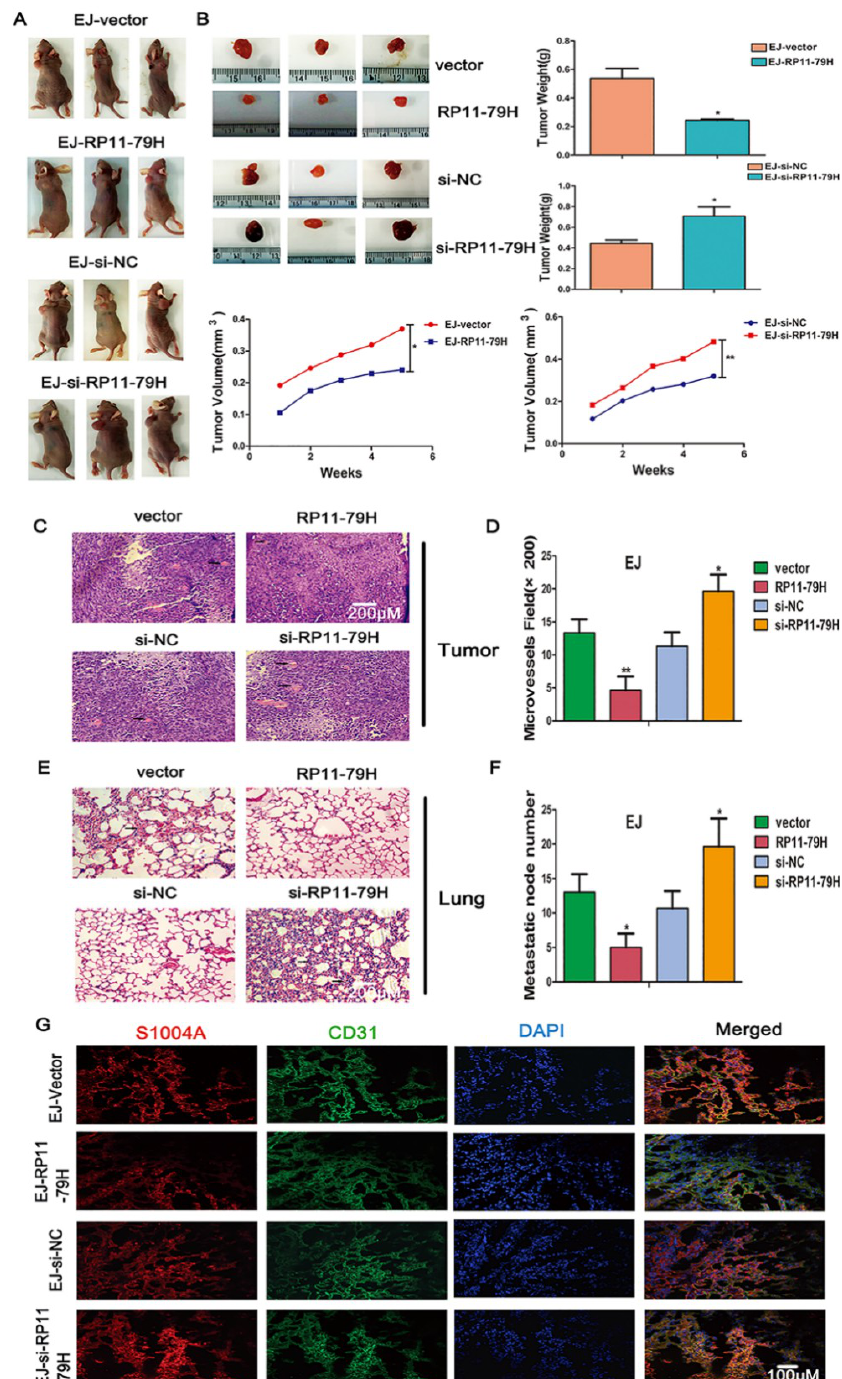
whereas si-RP11-79H23.3 led to a higher CD31 and S100A4 expression and more microvessels compared with the control group (Figure 4G).